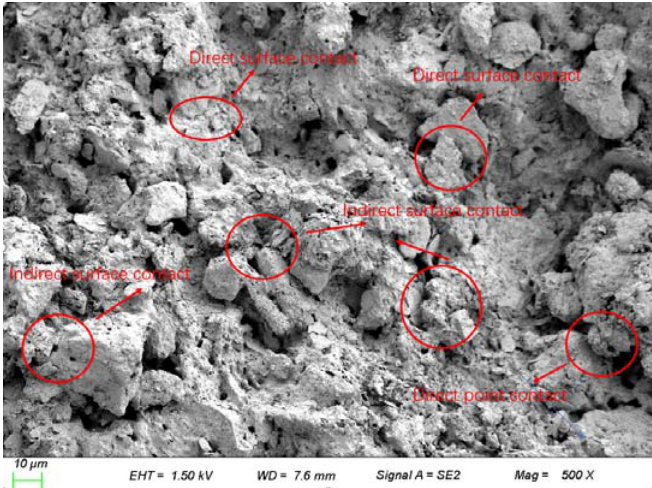
Figure 4. Particle contact state after MICP